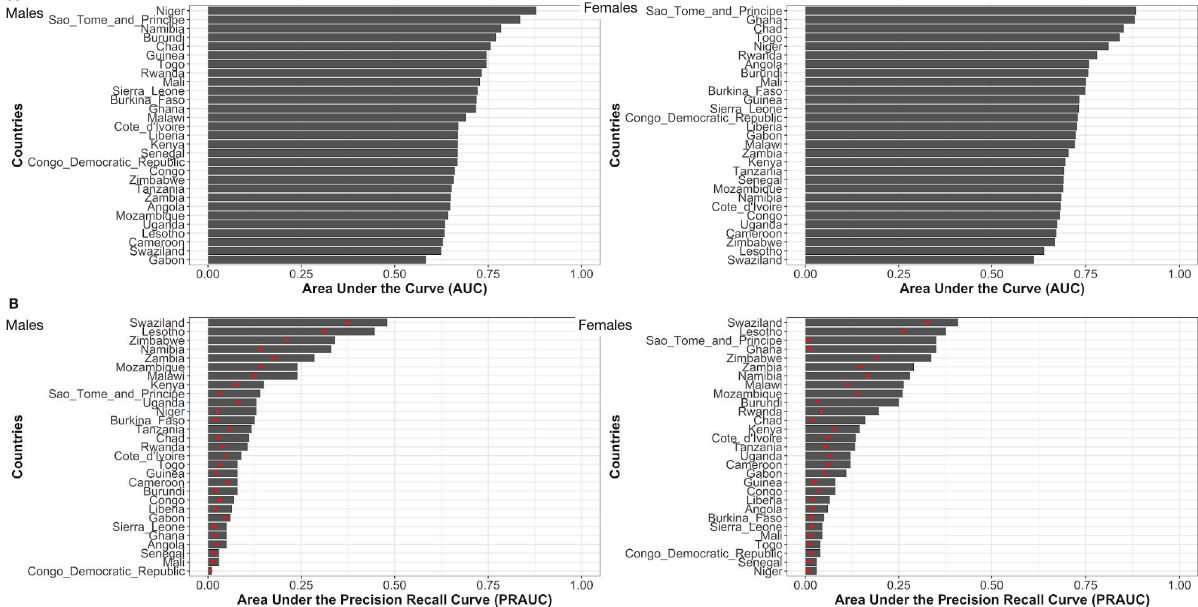
Fig. 4 Predictive capability of top 10 variables. A Area under the receiver-operator-curve (ROC) and B Are under the precision-recall curve. Left panels are prediction for males and right panel for females. Red points in B denote the prevalence of HIV + . Sample sizes for cases and controls for each AUC and precision-recall curve calculation are in Table S2.